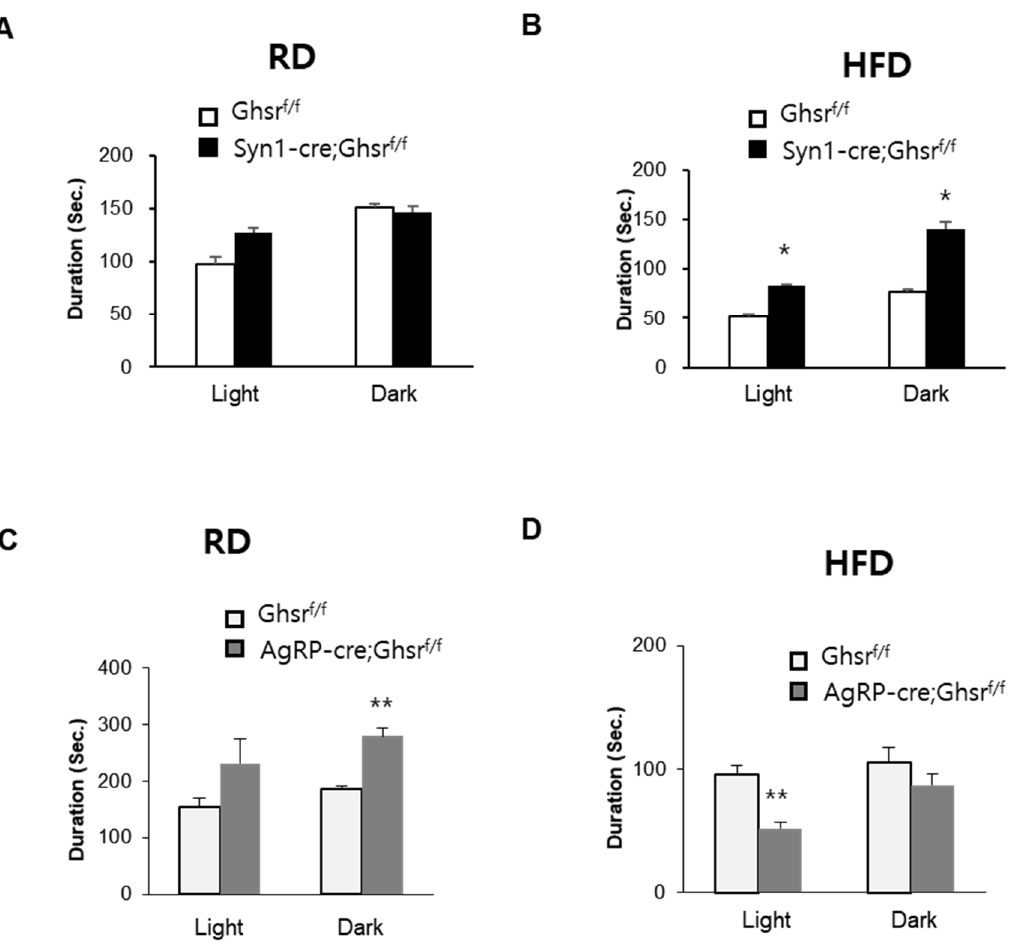
Figure 3. Duration in Syn1-Cre;Ghsr f/f and AgRP-cre;Ghsr f/f mice. RD ( A , C ) and HFD ( B , D ), n = 5, * p < 0.05, ** p < 0.01, Ghsr f/f vs. Syn1-Cre;Ghsr f/f or AgRP-cre;Ghsr f/f . All data are presented as means ± SEM.